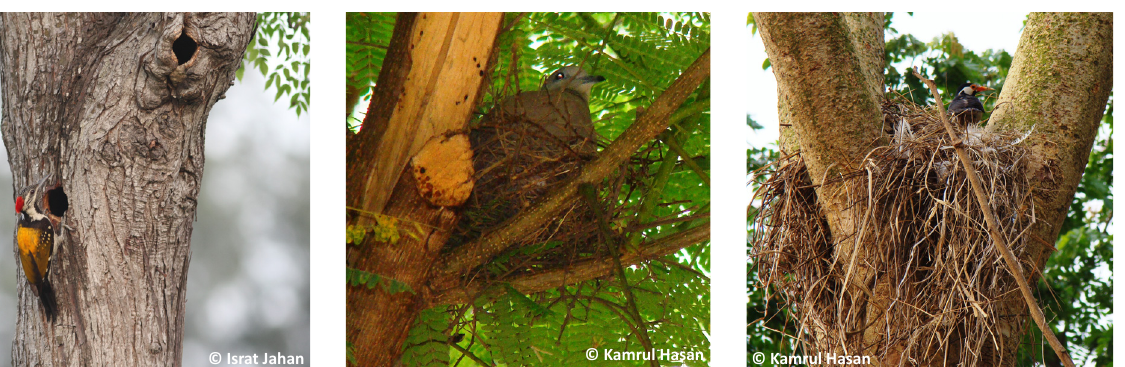
Image 11. Red Collared Dove